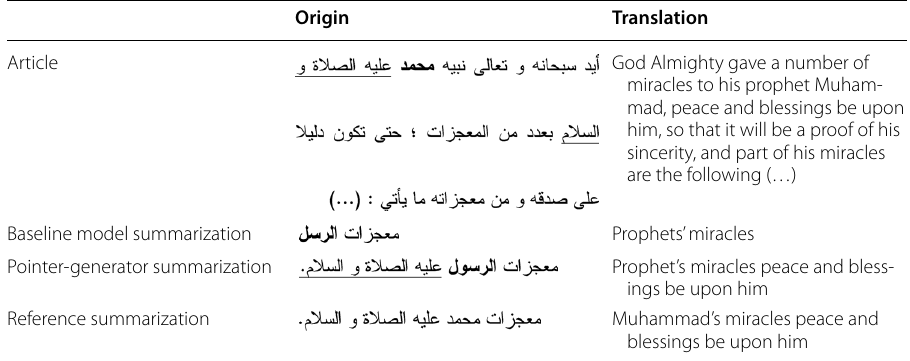
Table 1 Comparison between the results of the baseline model and the pointer-generator model